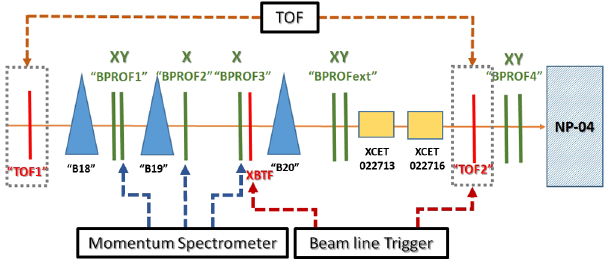
FIG. 10. An overview of the H4-VLE instrumentation, as discussed in the